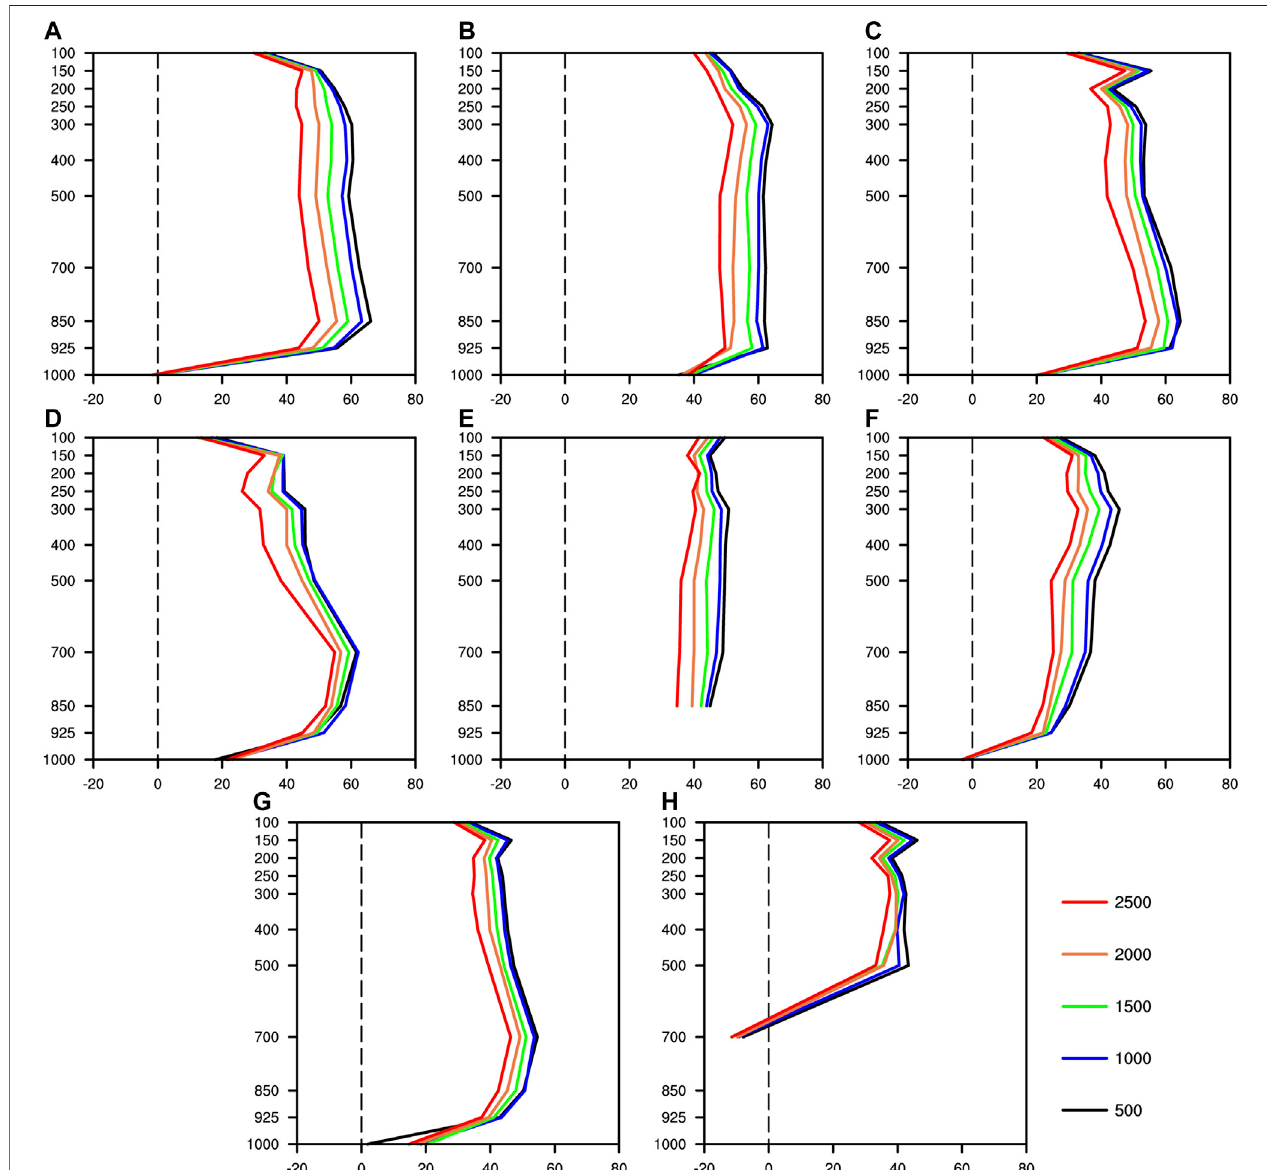
FIGURE9| Variation in RATE (%) of simulated meteorological fi elds at standard vertical level (hPa) under different cutoff wavelengths when all variables are nudged: (A) Northeast China; (B) North China; (C) East China; (D) South China; (E) East of Northwest China; (F) West of Northwest China; (G) Southwest China; (H)